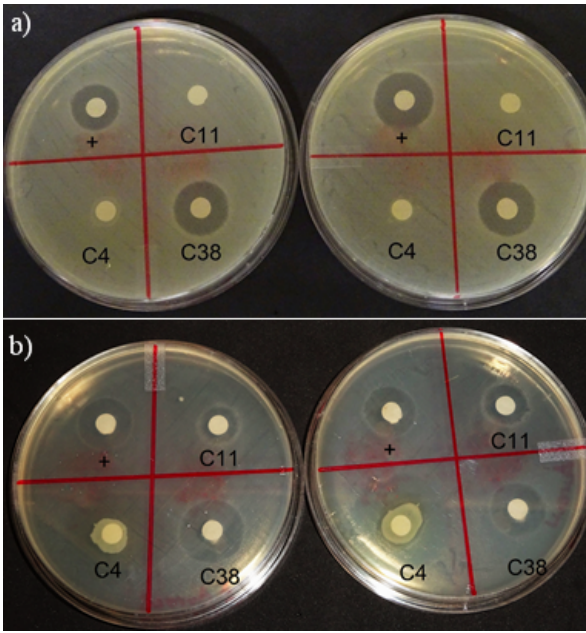
Figure 5: Antibacterial activity of Epiccocum sp (C38); Pheniophora sp (C11); Scopulariopsis sp (C4); Penicillum sp as a positive control (+) on duplicate Petri dishes. a) against S. aureus , b) against E. coli